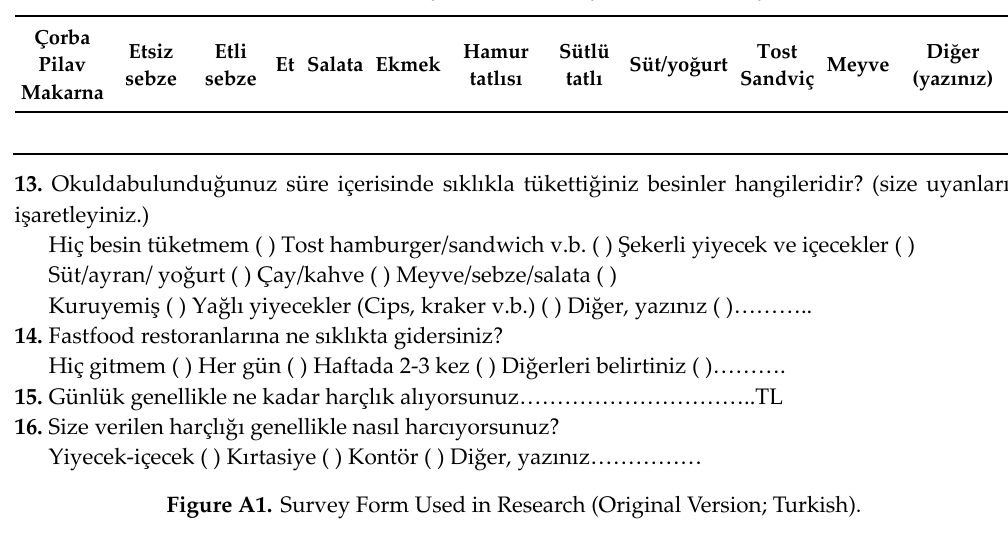
Figure A1. Survey Form Used in Research (Original Version; Turkish).